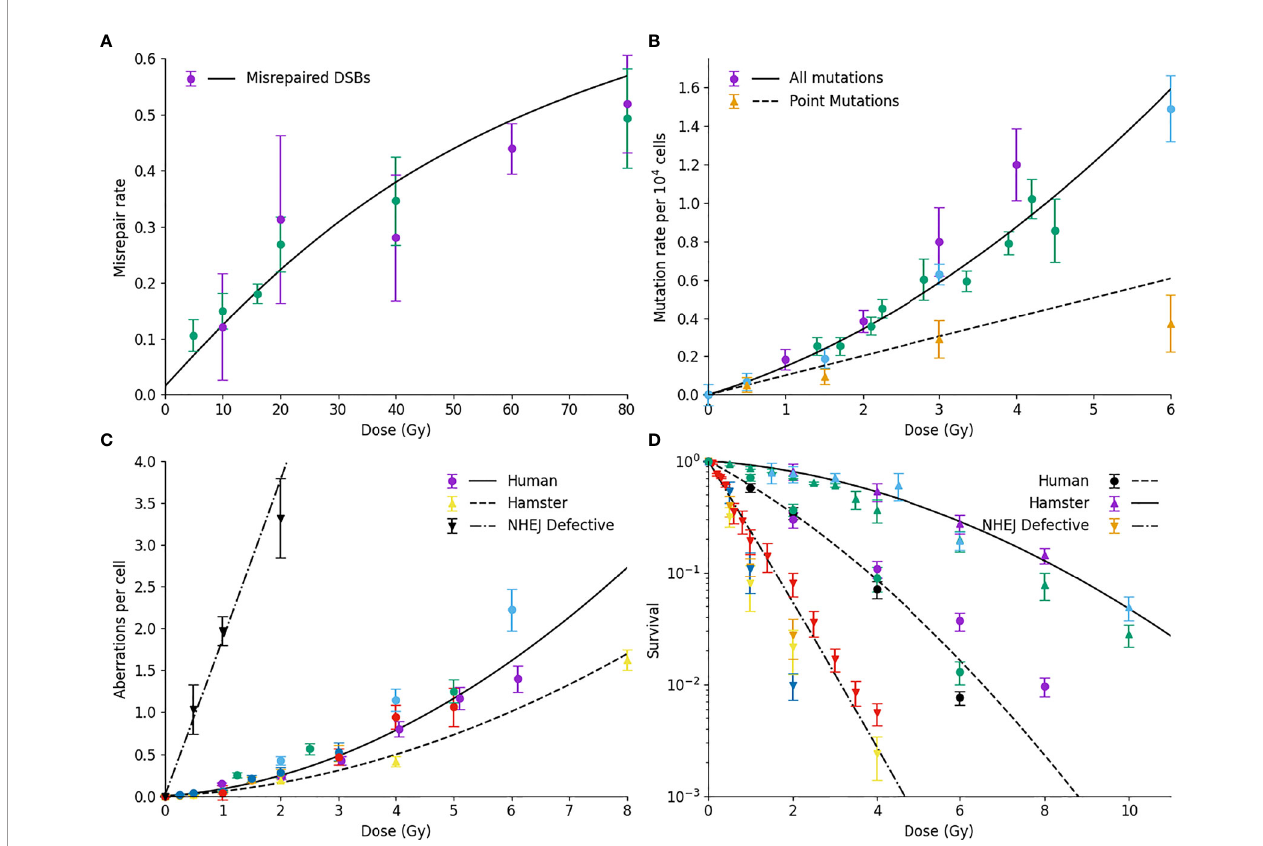
FIGURE 3 | Comparison of model prediction and misrepair endpoints. (A) Model prediction (line) compared to observed rates of DSB misrejoining. (B) Mutation rates of HPRT gene, considering either all mutations (circles, line) or only point mutations (triangles, dashed line); (C) Chromosome aberration yield, for normal human cells (circles, line), human-hamster hybrid cells (upwards triangle, dashed line) or NHEJ-defective human cells (downward triangles, dash-dot line); (D) Cell survival for normal Chinese hamster (solid line, triangles), normal human (dashed line, circles) or NHEJ-defective hamster (dash-dot line, downward triangle) cells. For all plots, colours are used to indicate different data